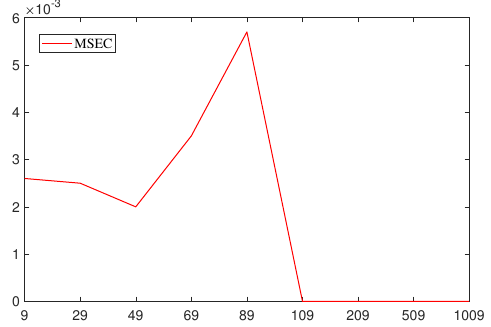
Figure 1. Folding line plot of the mean square error for a variance of 0.5.